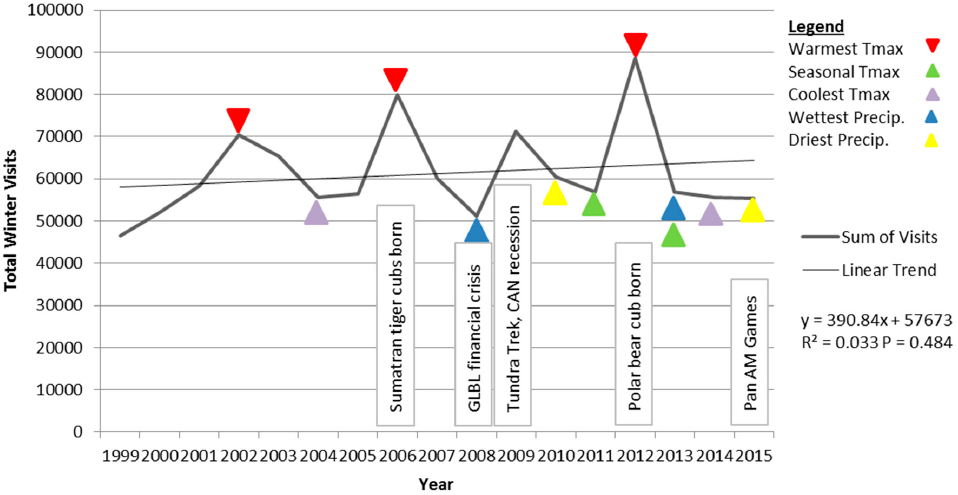
Figure 2. Total zoo visitation by year for the winter season, indicating climatic anomalies, climate normals, and other non-climatic factors from 1999 to 2015.